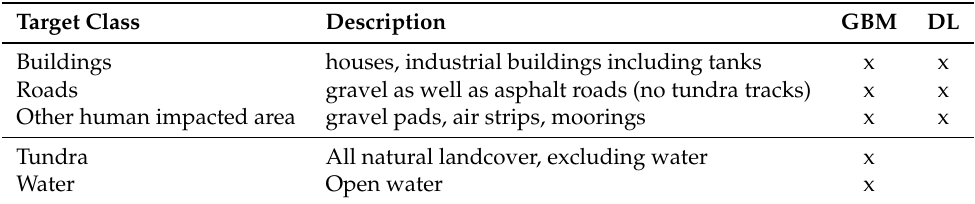
Table 3. Target class descriptions and use for Gradient Boost Machines (GBM) and Deep Learning (DL),